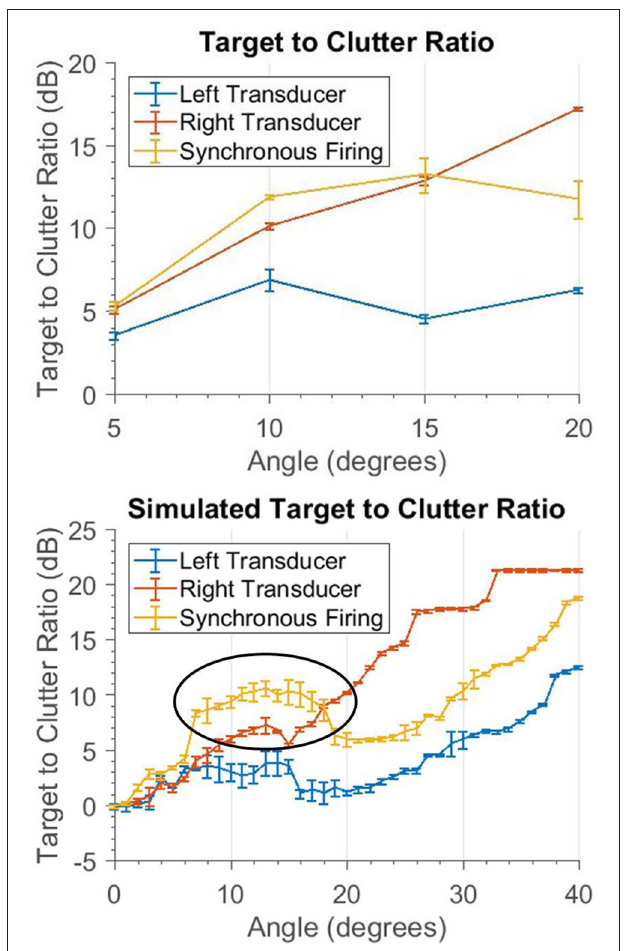
FIGURE 14 | These graphs show how a clutter object appears at different angles. The target and clutter objects are at the same range. Only the angle to the clutter object is changed. The top graph shows the ratio of the target and clutter amplitude. The bottom shows simulated data, where only one object was scanned across all of the angles. The ratio was computed using the echo at angle 0 (i.e., the target) and the other angles (i.e., the clutter object). The circled area shows that for angles less than 18 ◦ the synchronous firing has better clutter